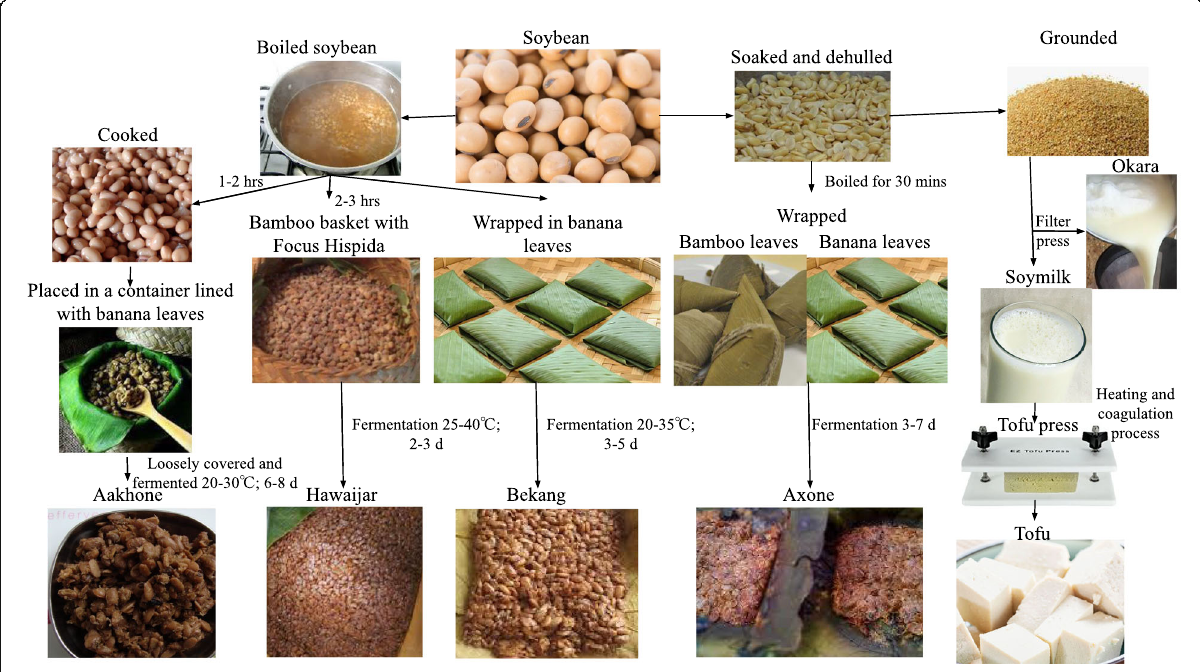
Fig. 4 Fermentation process of boiled and dehulled